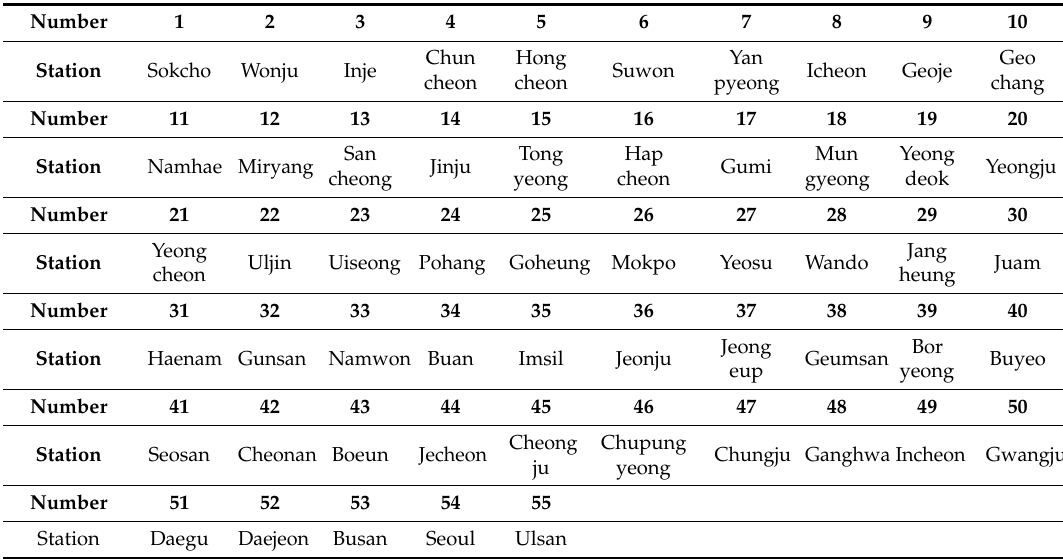
Table 2. Numbers of rainfall gauge